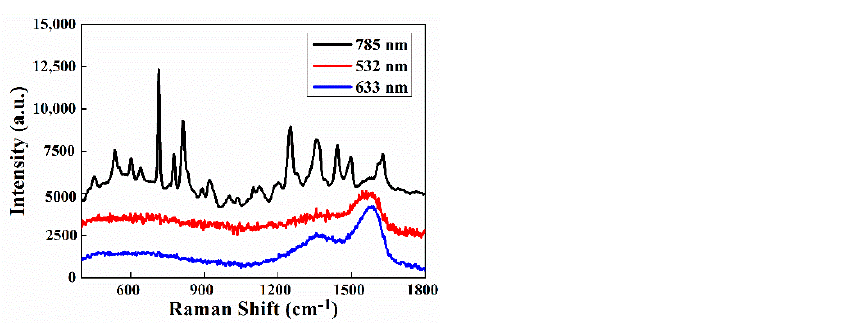
Figure 8. SERS spectra of 10 − 6 mol/L R6G solutions mixed with Fe 3 O 4 @Au NPs with different volume ratios, recorded on sandwich structures.